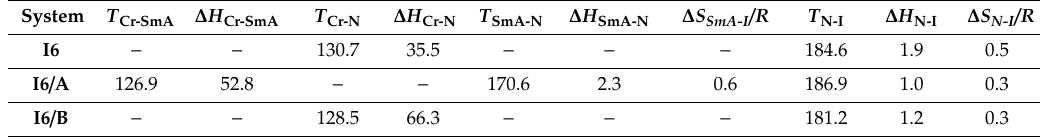
Table 1. Phase transition temperatures upon heating (T; °C), enthalpy of transitions ( ∆ H ; kJ/mol), and normalized transition entropy ( ∆ S/R ) of the base I6 and its supramolecular complexes, I6/A and I6/B.